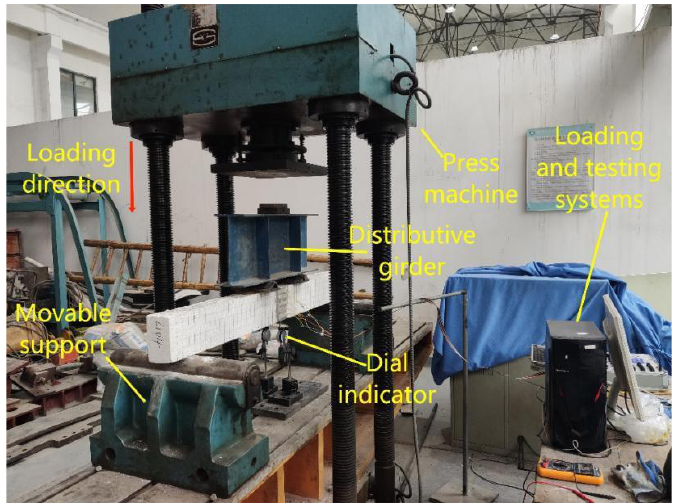
Figure 6. Snapshot of static load test.